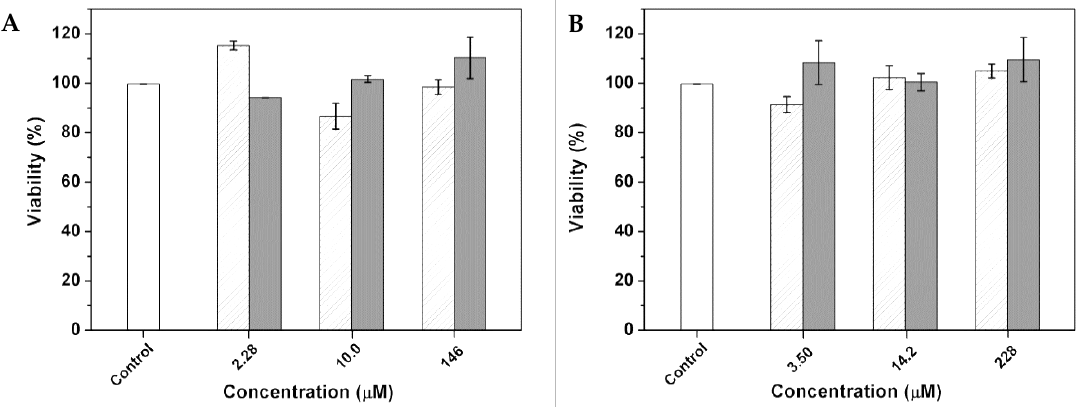
Figure 14. Viability of NCI-H460 tumor cells exposed to drug-loaded nanocarriers containing MnFe 2 O 4 /Au core/shell NPs (dashed column) and containing MnFe 2 O 4 decorated with Au NPs (grey column), without irradiation. ( A ) Compound 1 ; ( B ) Compound 2 . Table 8. Growth inhibitory concentrations (GI 50 ) in NCI-H460 lung cancer cell line. The results are